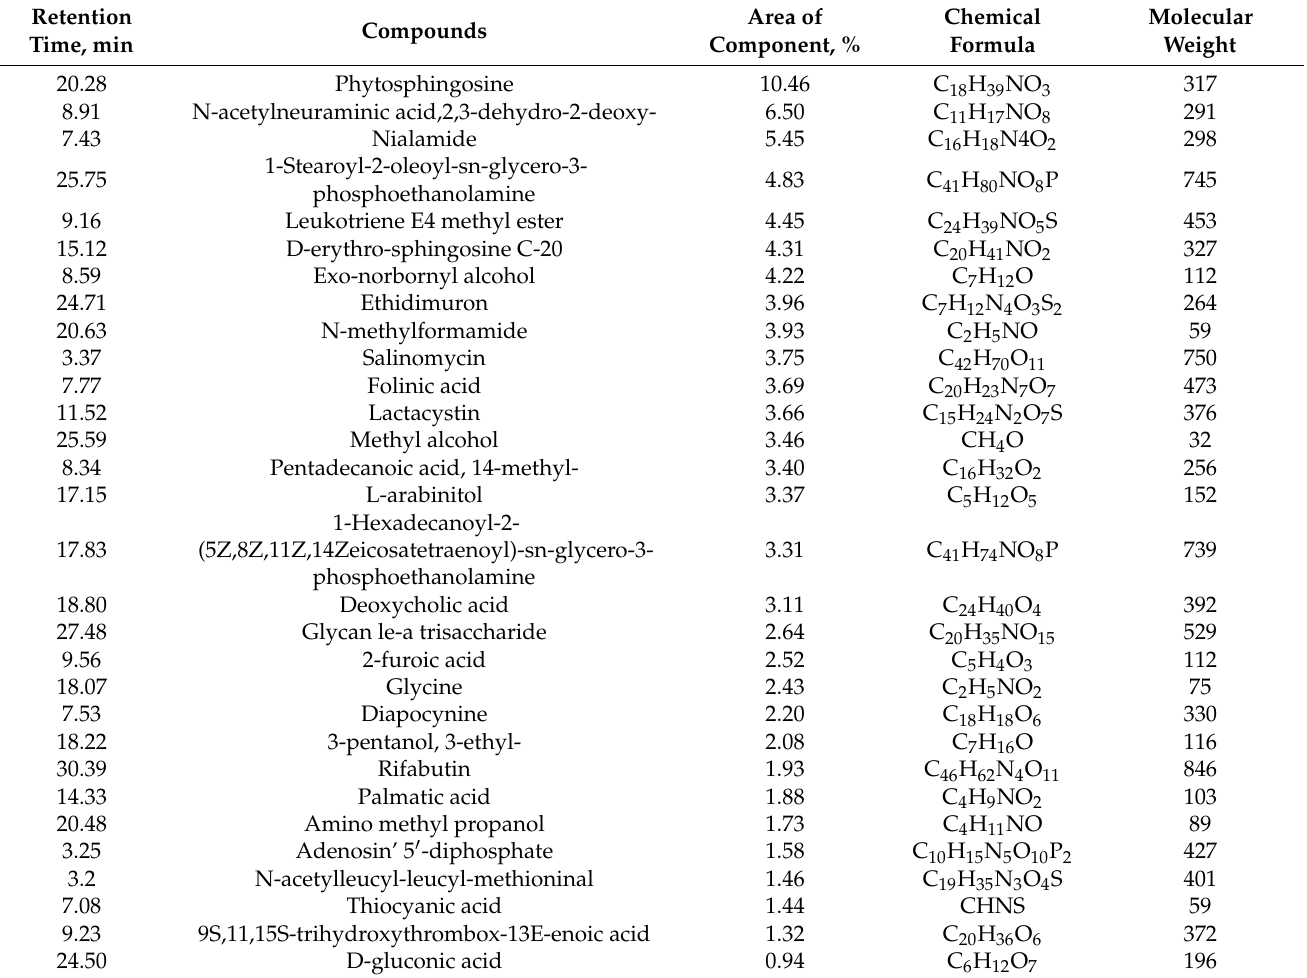
Table 2. Chemical composition of a Moringa leaf ethanolic